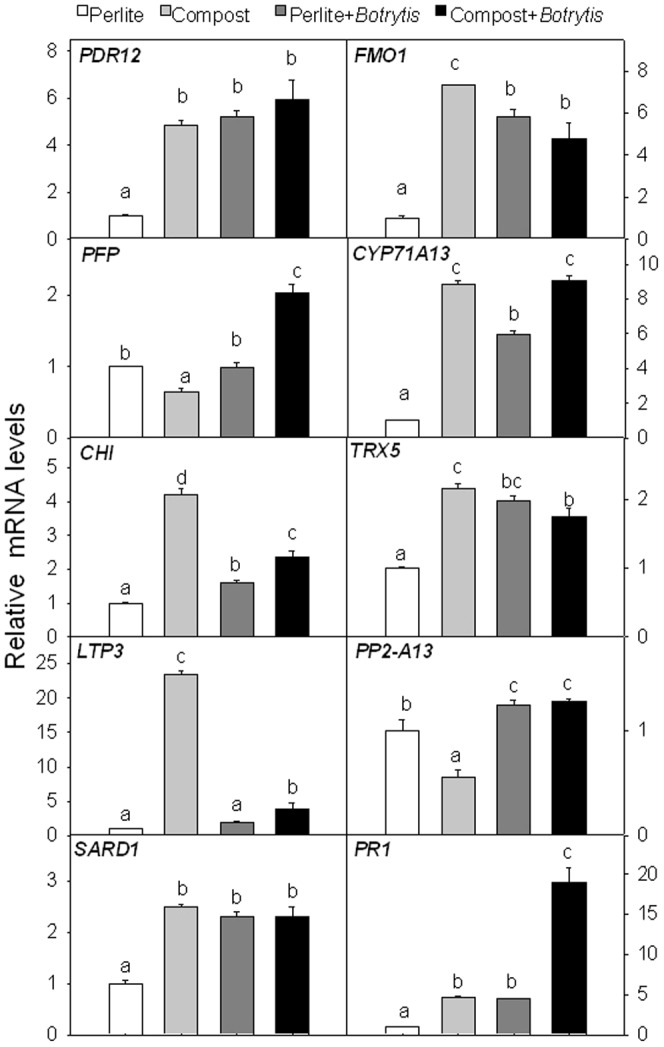
Expression levels of ten differently expressed genes in Arabidopsis plants inoculated with B. cinerea.Expression levels of PLEIOTROPIC DRUG RESISTANCE 12 (PDR12), FLAVIN-DEPENDENT MONOOXYGENASE 1 (FMO1), PECTINACETYLESTERASE FAMILY PROTEIN (PFP), CYTOCHROME P450 (CYP71A13), CHITINASE (CHI), THIOREDOXIN H-TYPE 5 (TRX5), LIPID TRANSFER PROTEIN 3 (LTP3), PHLOEM PROTEIN 2-A13 (PP2-A13), SAR DEFICIENT 1 (SARD1) and PATHOGENESIS-RELATED GENE 1 (PR1) in Arabidopsis Col-0 leaves of plants grown in either perlite or olive marc compost 3 days after inoculation with Botrytis cinerea (3-µl drops of a 106 conidia mL−1 suspension was applied to alternate mature leaves). Control plants were treated with buffer without conidia. For reference, expression values of control plants grown in perlite are set at 1. Gene expression was corrected with the constitutively expressed reference gene At1g13320. Different letters indicate significant differences in a Duncan's multiple-range test, P<0.05; data shown are means ± SE, n = 3.